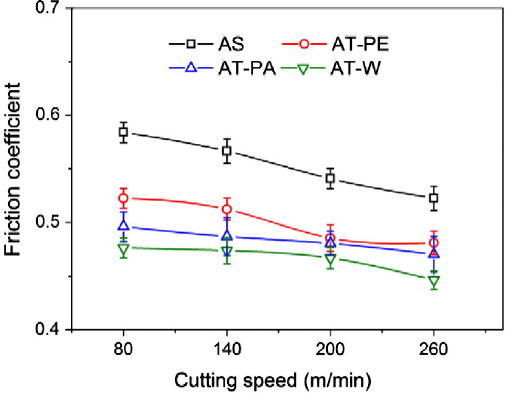
Figure 6. Friction coefficient at the tool–chip interface of four kinds of tools at different cutting speeds ( a p = 0.2 mm, f = 0.2 mm/r) [74].